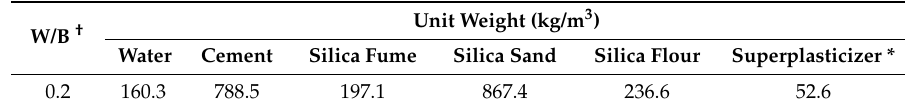
Table 1. Mixture proportions for